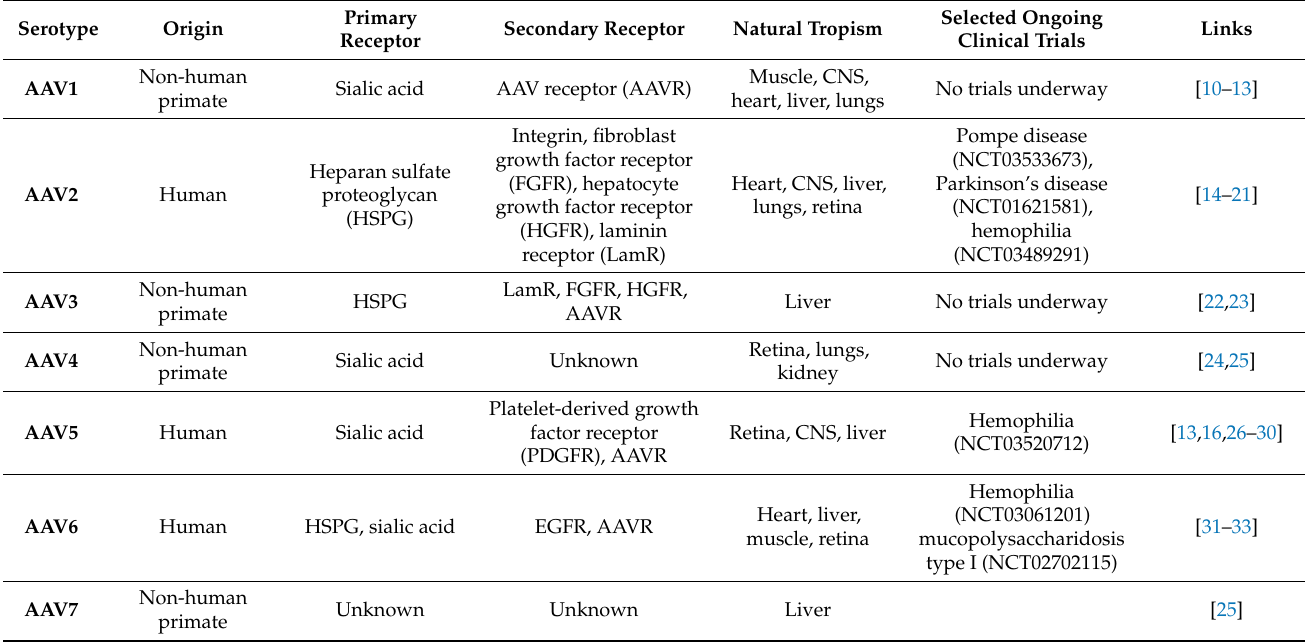
Table 1. Characterization of AAV natural